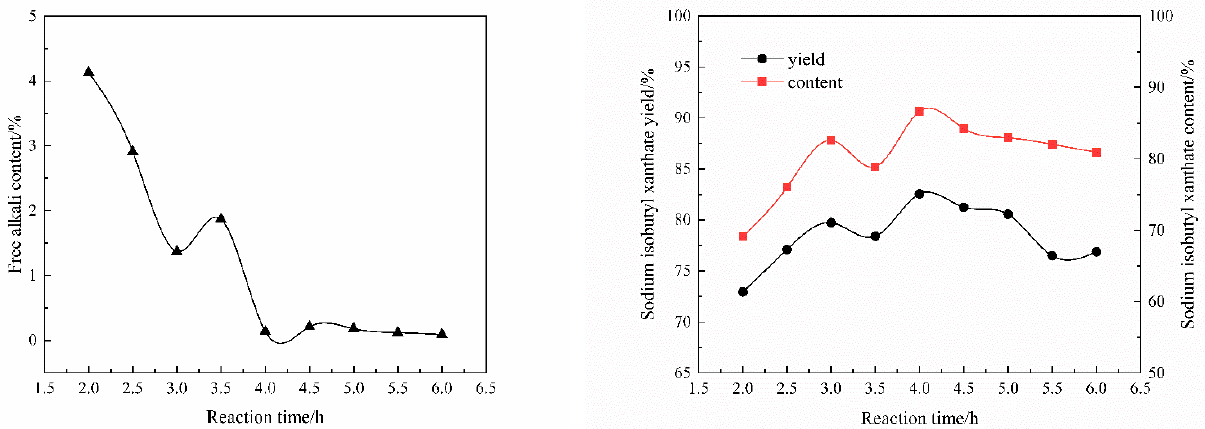
Figure 4. The effect of reaction time: ( a ) The content of free alkali; ( b ) The content and yield of sodium isobutyl xanthate.